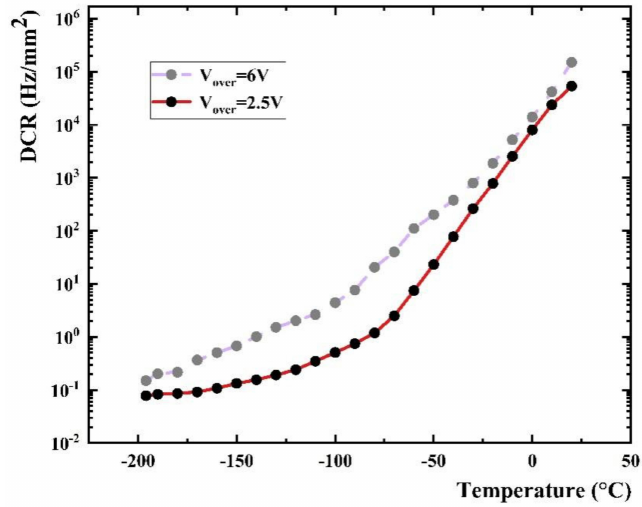
Figure 7. DCR vs. temperature, V over = 2.5 V and V over = 6 V.